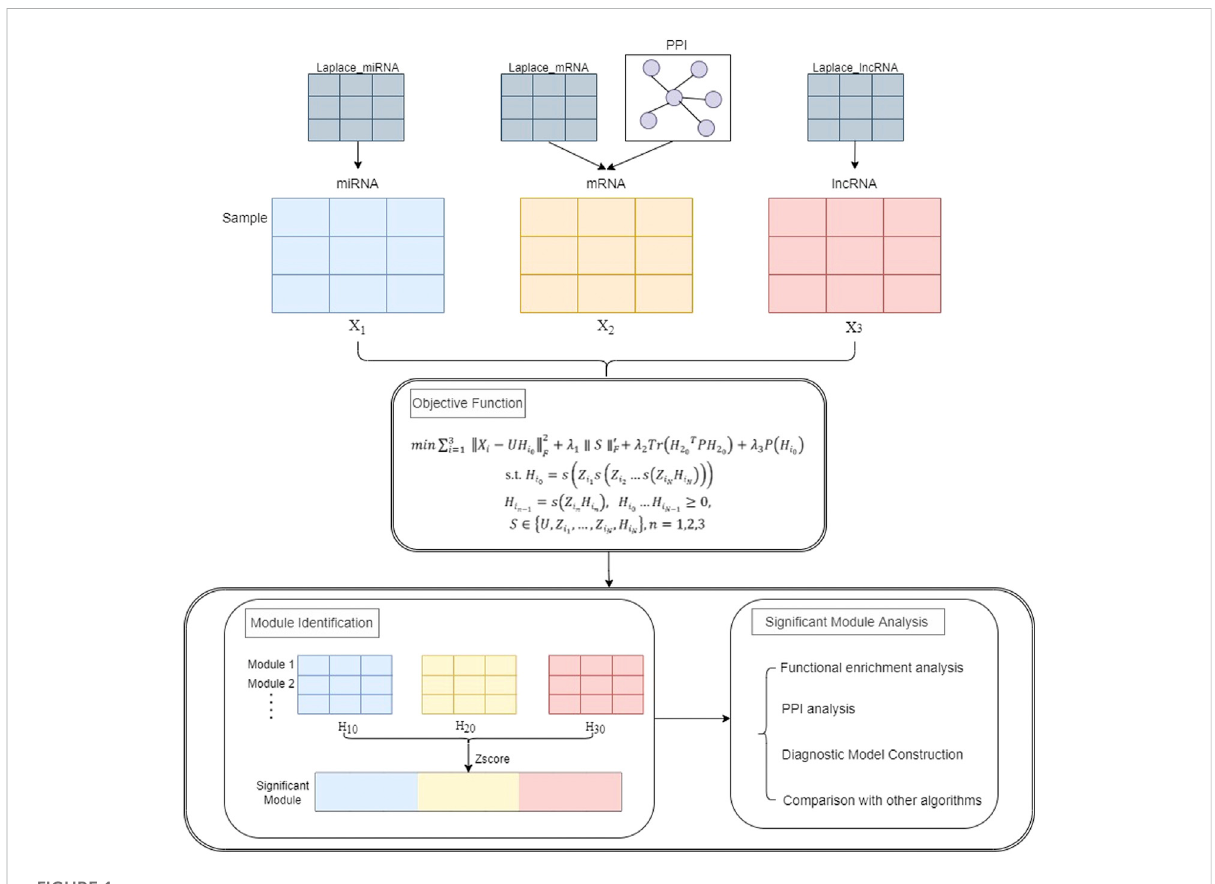
FIGURE 1 The overall fl ow chart of the